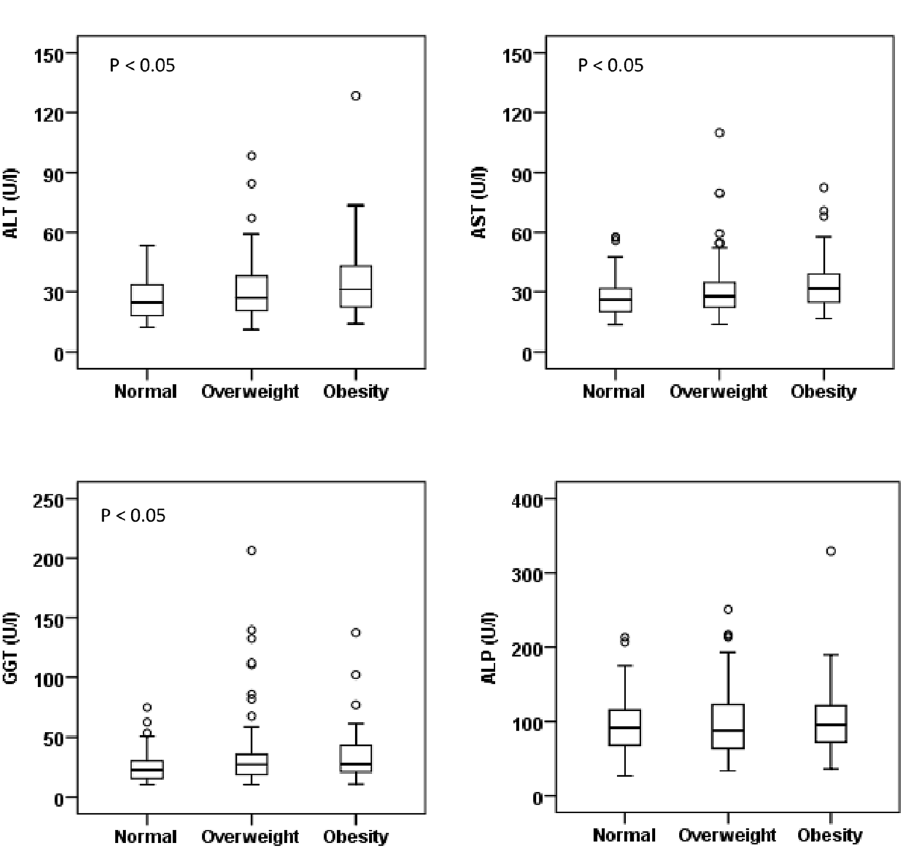
Figure 1. Levels of serum liver enzymes in the BMI groups (n = 173 in normal, n = 259 in overweight and n = 108 in obesity group). P-values are obtained from one-way ANOVA (Dunnett’s Post Hoc Test). *P < 0.05 when the mean level of liver enzymes in the normal group is compared to the obesity